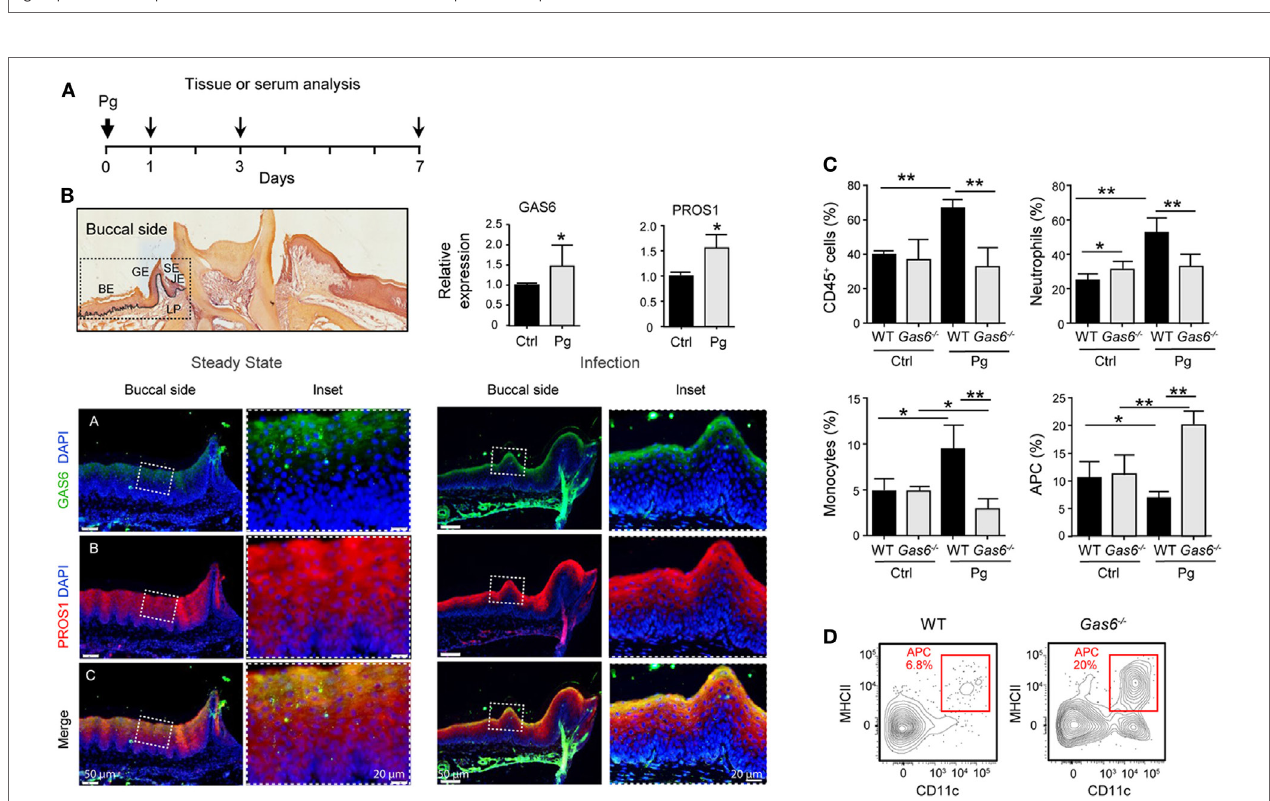
FigUre 3 | Lack of innate infiltrate in the gingiva of infected Gas6 − / − mice. (a) Schematic presentation of an acute oral infection. Mice were infected once with Pg by oral gavage and analyzed either 1, 3, or 7 days after infection. (B) H&E and immunofluorescence stained histological section of the lower jaw and RT- q PCR analyses of GAS6 and PROS1 expression in the gingiva of WT mice prior to and 3 days after Pg infection. Bar graphs represent the mean of four mice per group ± SEM. Immunohistochemical staining is shown for GAS6 (green), PROS1 (red) and nuclei are stained with hoechst (blue). Enlarged images of the framed area are shown to the right. (c) Percentages of total CD45 + cells, neutrophils, monocytes, and APCs in the gingiva 24 h after infection. Bar graphs represent the mean of five mice per group ± SEM. (D) Representative FACS plot showing the frequencies of MHCII + CD11c + cells (APCs) in the gingiva of WT and Gas6 − / − mice 24 h after infection. Representative data of one out of three independent experiments is shown. Abbreviations: BE, buccal epithelium; GE, gingival epithelium; SE, sulcular epithelium; JE, junctional epithelium; LP, lamina propria; GAS6, growth arrest-specific 6.